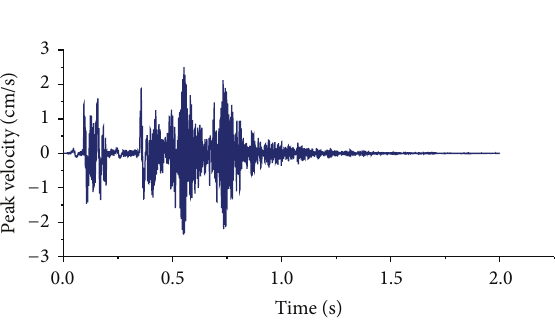
Figure 10: Velocity curves in surrounding rock.